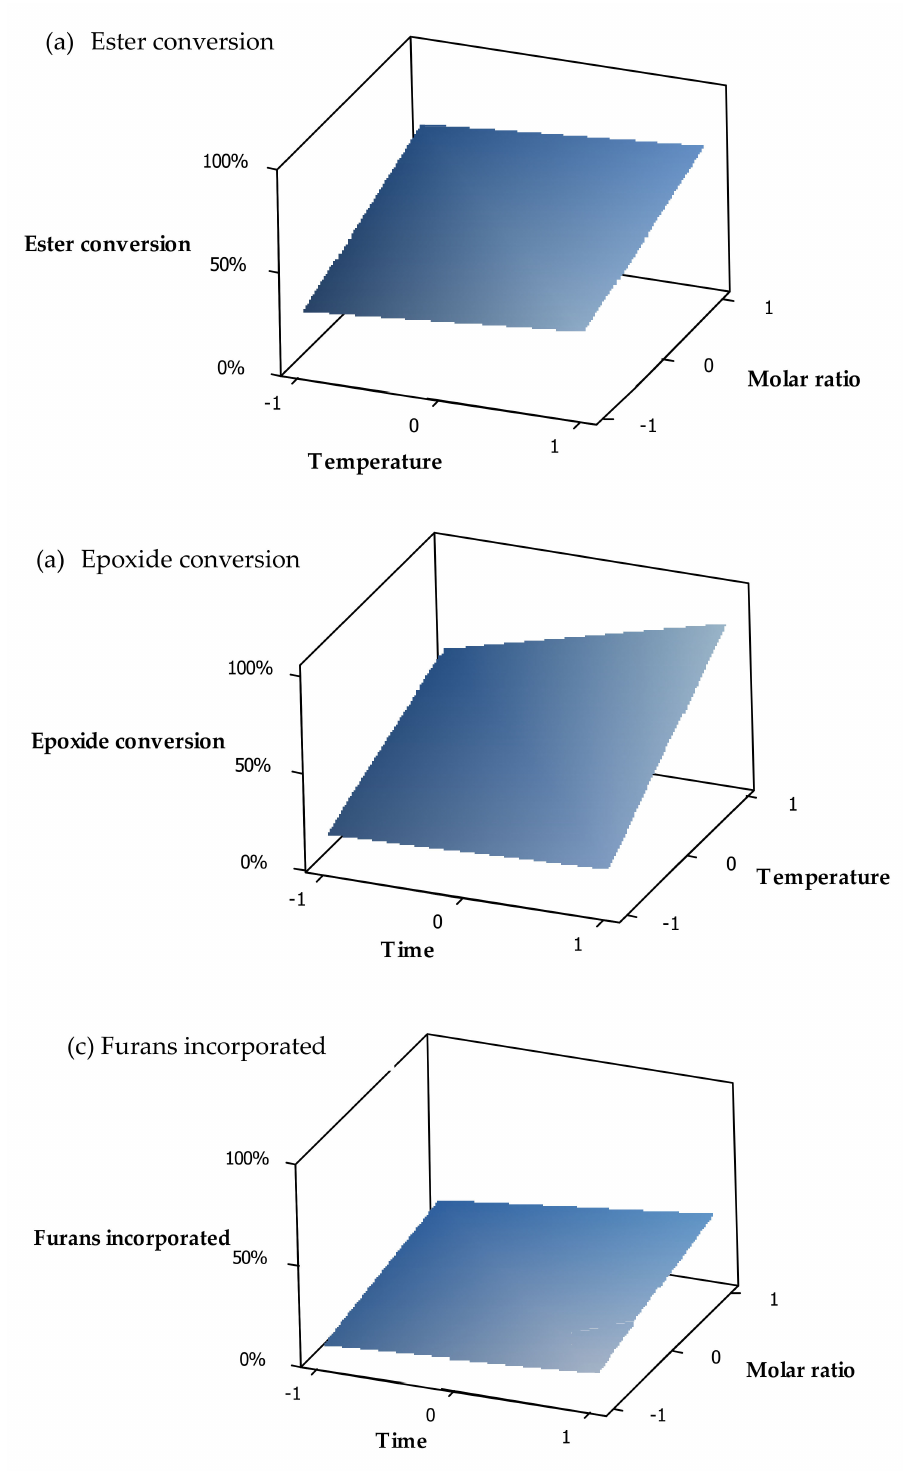
Figure 6. Surface plots for various responses: ( a ) ester conversion, ( b ) epoxide conversion, and ( c ) furans